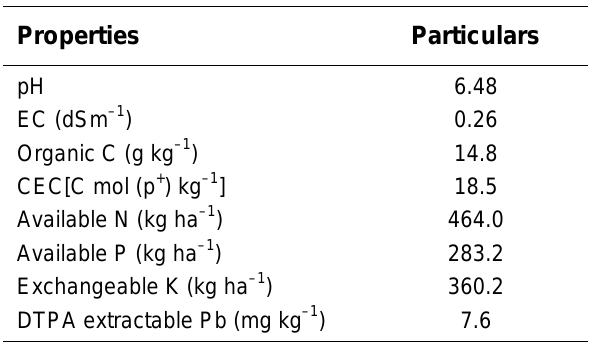
Physicochemical Properties of the Experimental